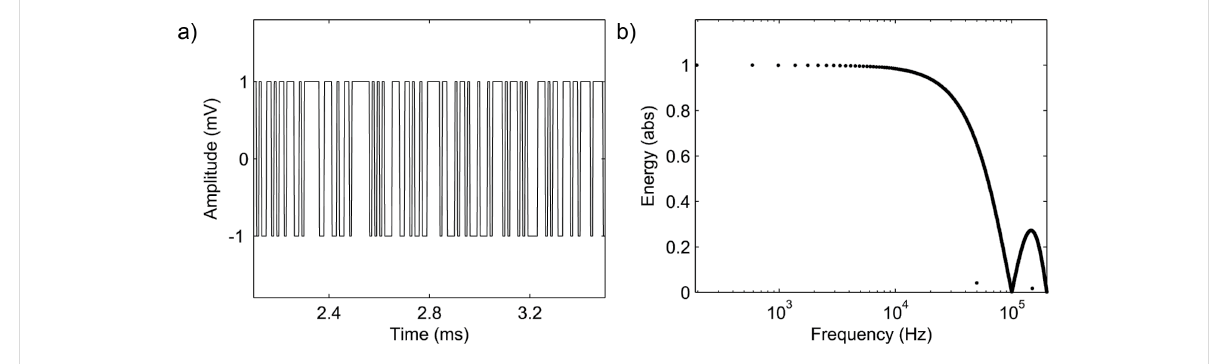
Figure 10: Generated excitation sequence; a) sample in the time domain, and b) (scaled) energy content.